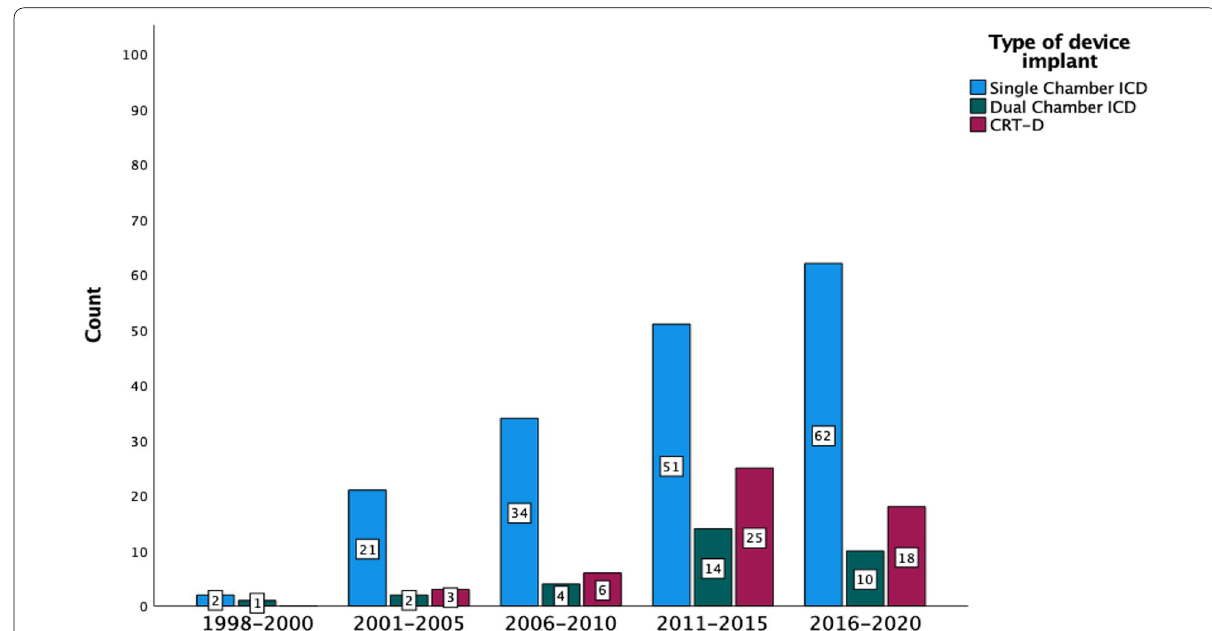
Fig. 2 Stalked Bar Chart demonstrating an increase in implantation of Dual-chamber ICD and CRT-D on the background of an overall rise in single-chamber devices. No =